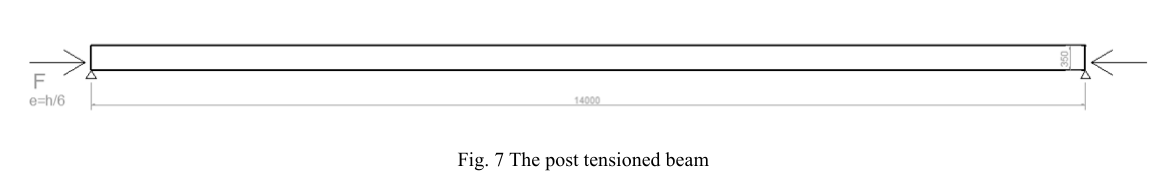
Fig. 7 The post tensioned beam